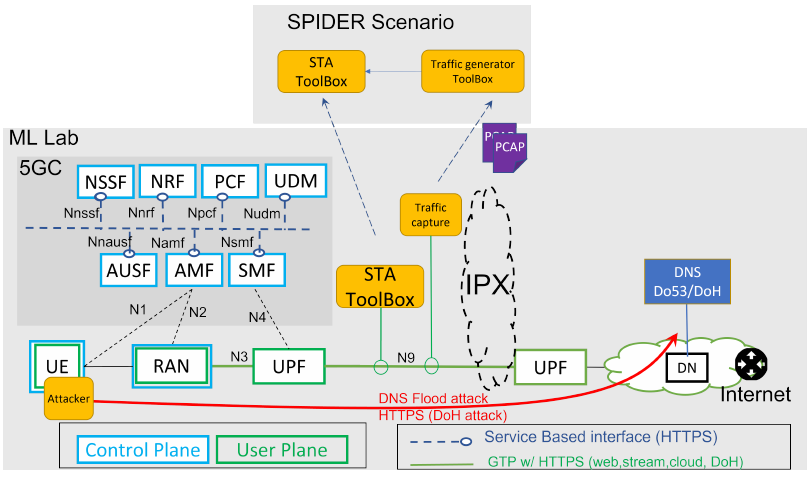
Figure 11. DNS attack